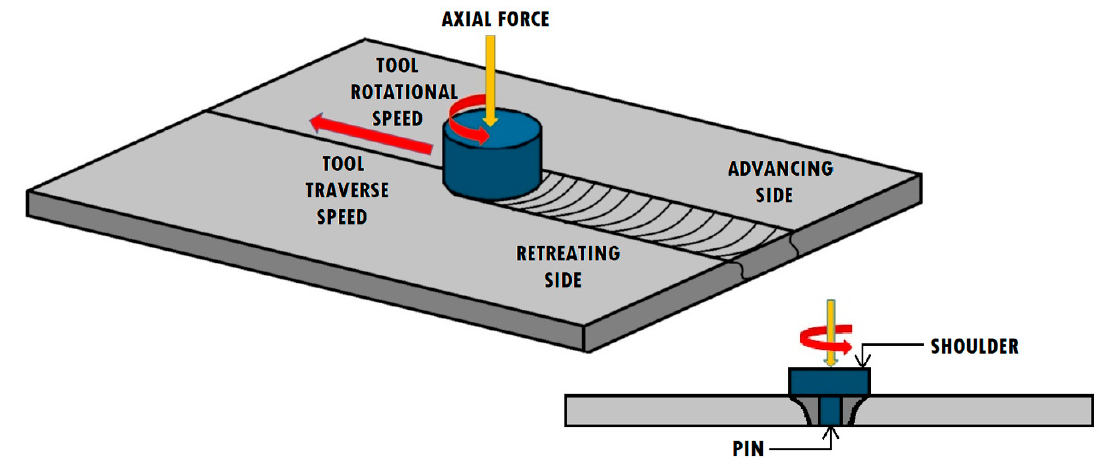
Figure 1. Schematic illustration of a friction stir welding process.